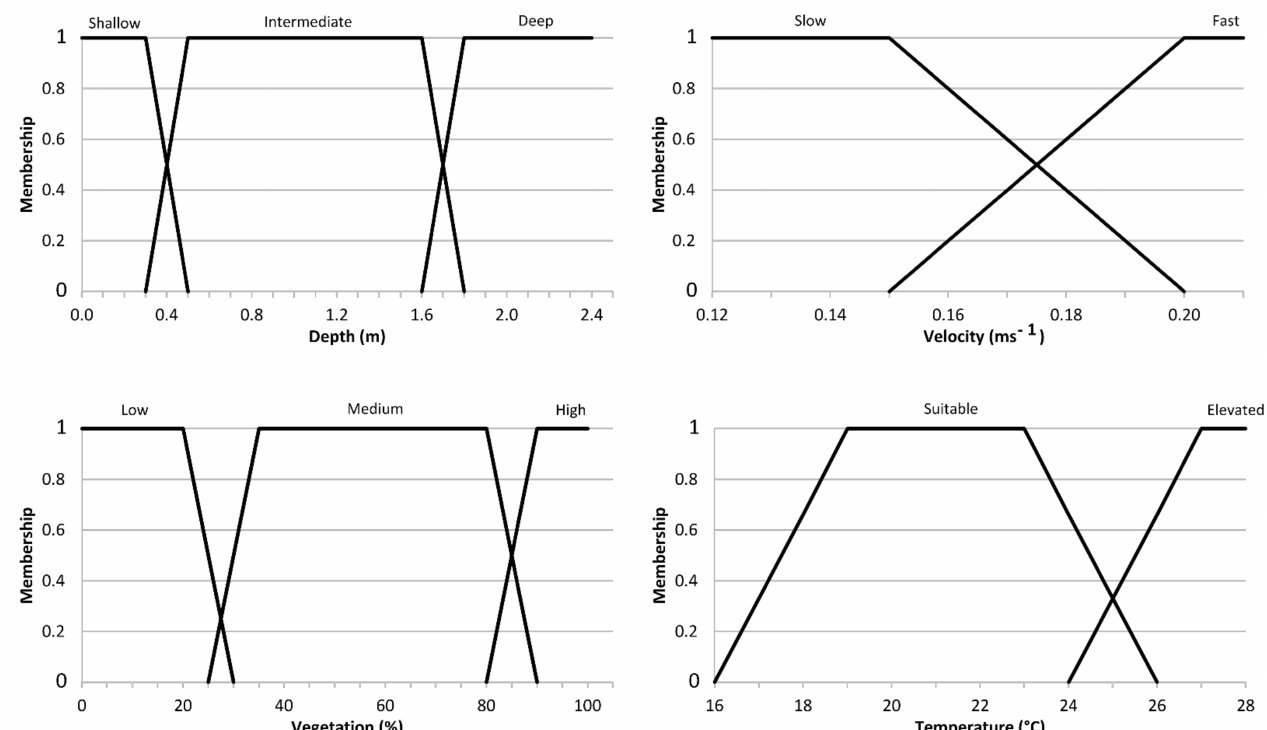
Figure 2. Linguistic values and membership functions for each variable used in carp spawning habitat